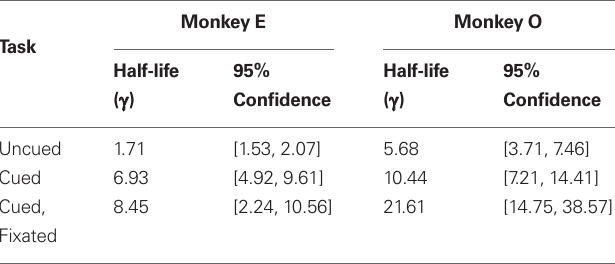
Fixated Values less than 10 − 4 are recorded as 0. Table 4 | Half-lives and confidence intervals across task conditions.